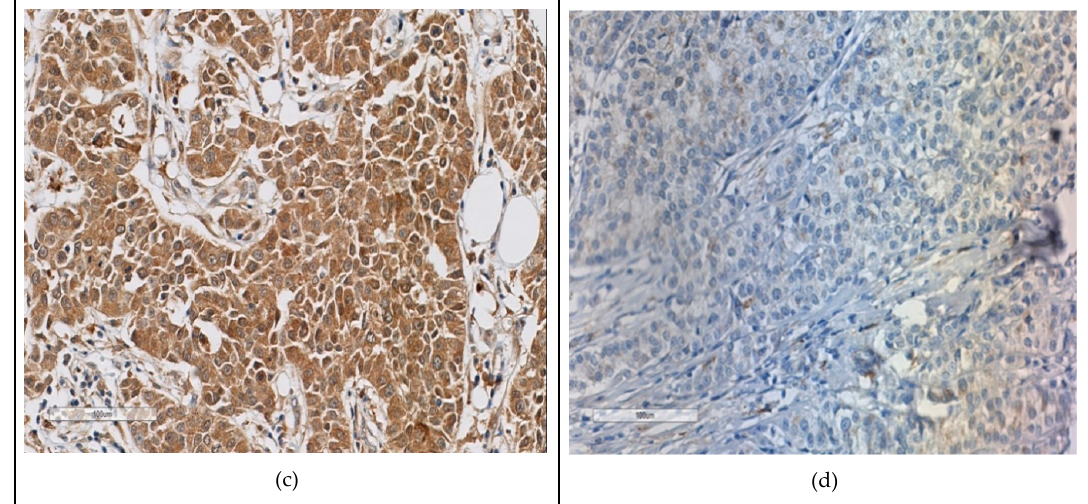
Figure 2. Immunohistochemichemical expression of LKB1 in Breast cancer cells. ( a– c ) Positive cytoplasmic expression, ( d ) LKB1 negative.